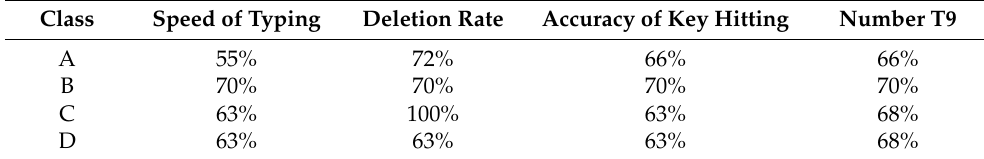
Table 8. Weights in all parameters of the four classes.